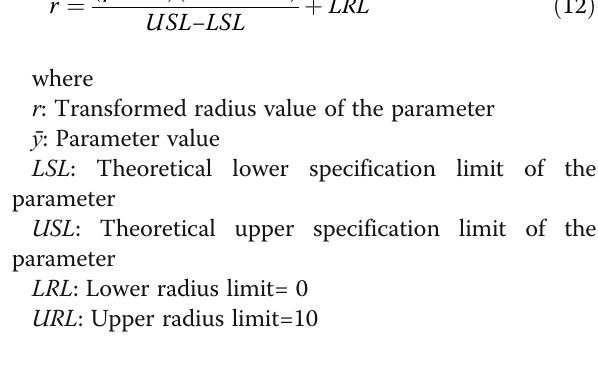
Calculation of flowability and compressibility functions, lubricity/dosage, and composite